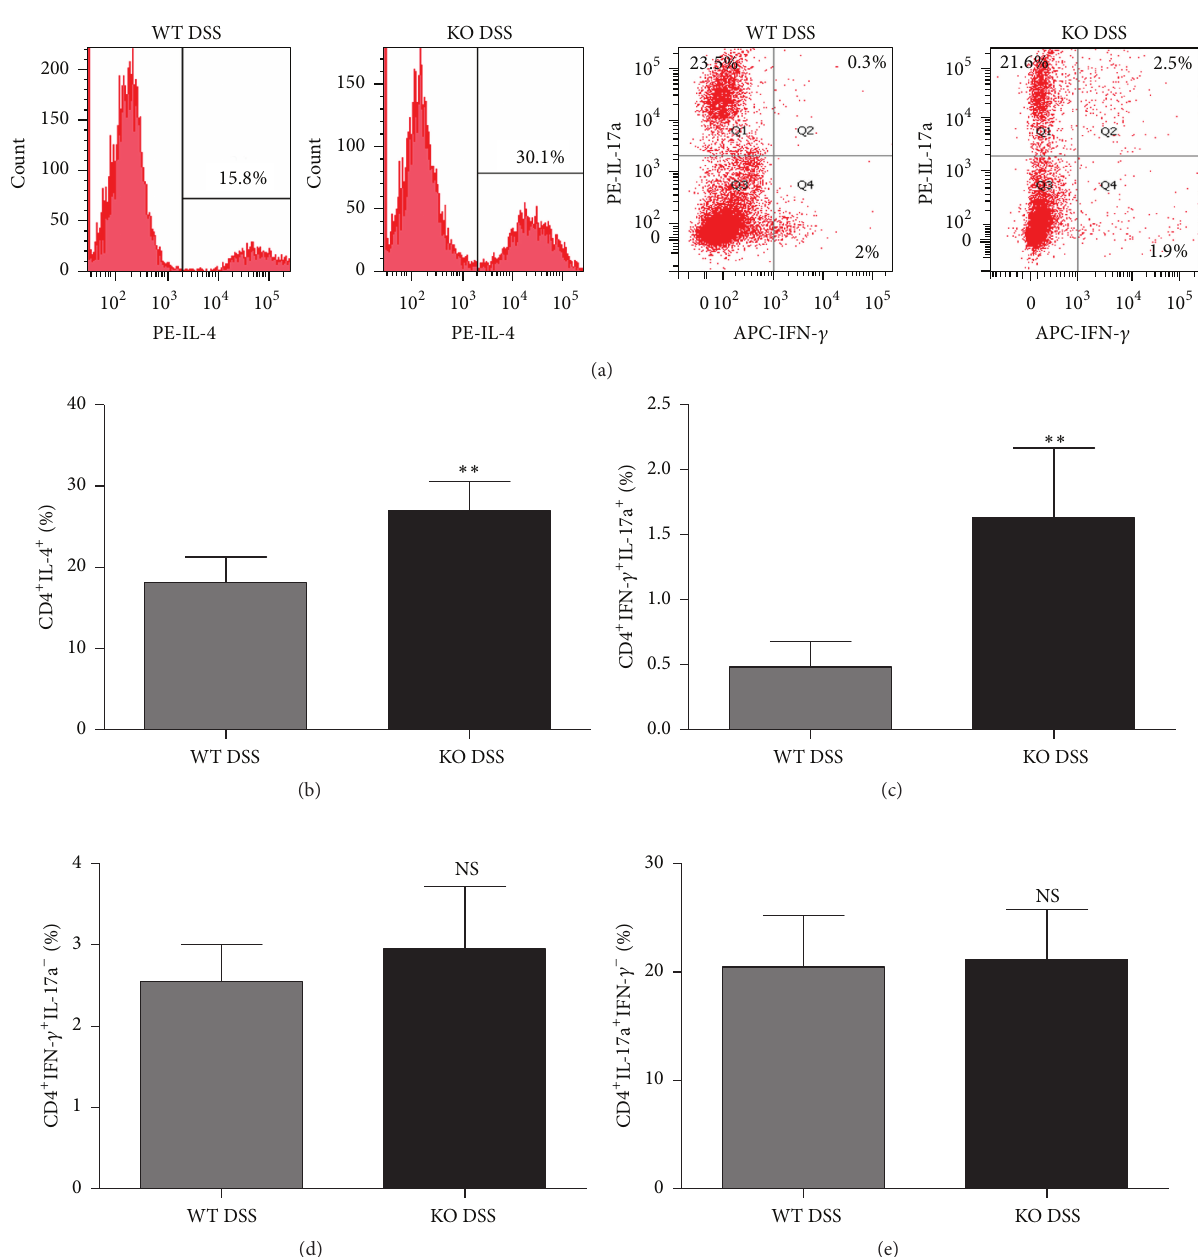
Figure 5: Increased proportions of Th2 and IFN- 𝛾 /IL-17a-coproducing CD4 + T cells in the colons of TRAF5-deficient animals induced by DSS. LPMCs obtained from the colons of DSS-fed KO and WT mice were stimulated with PMA/ionomycin and subjected to surface staining for CD4. After fixation and permeabilization, intracellular staining for IL-4, IFN- 𝛾 , and IL-17a was performed as described in Section 2. CD4 + T cells were then gated and analyzed. (a) Representative flow plots. The percentages of (b) Th2 cells (CD4 + IL-4 + ), (c) IFN- 𝛾 /IL-17a- coproducing CD4 + T cells (CD4 + IFN- 𝛾 + IL-17a + ), (d) classical Th1 cells (CD4 + IFN- 𝛾 + IL-17a − ), and (e) classical Th17 cells (CD4 + IL-17a + IFN- 𝛾 − ) are presented as the mean ± SD. The data are representative of 3 independent experiments. 𝑁 = 6 per group. ∗∗ 𝑝 < 0.01 versus the DSS-treated WT group. NS: not significant versus the DSS-treated WT